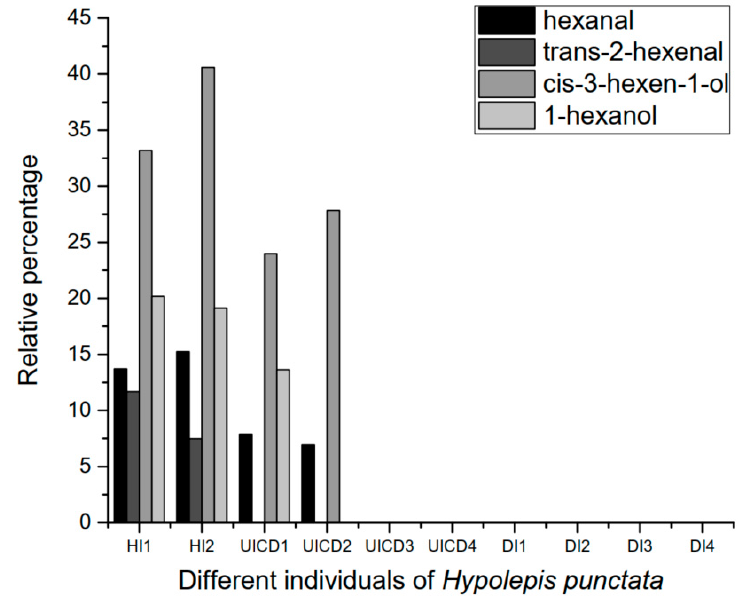
Figure 2. Relative percentages of amounts of four green leaf volatiles in each individual of Hypolepis punctata . The Y-axis is the relative percentage of four green leaf volatiles, of which each is represented with a unique color. The X-axis shows ten individuals of Hypolepis punctata . HI = healthy individuals, UICD= undamaged individuals that are close to damaged individuals, DI = damaged individuals.